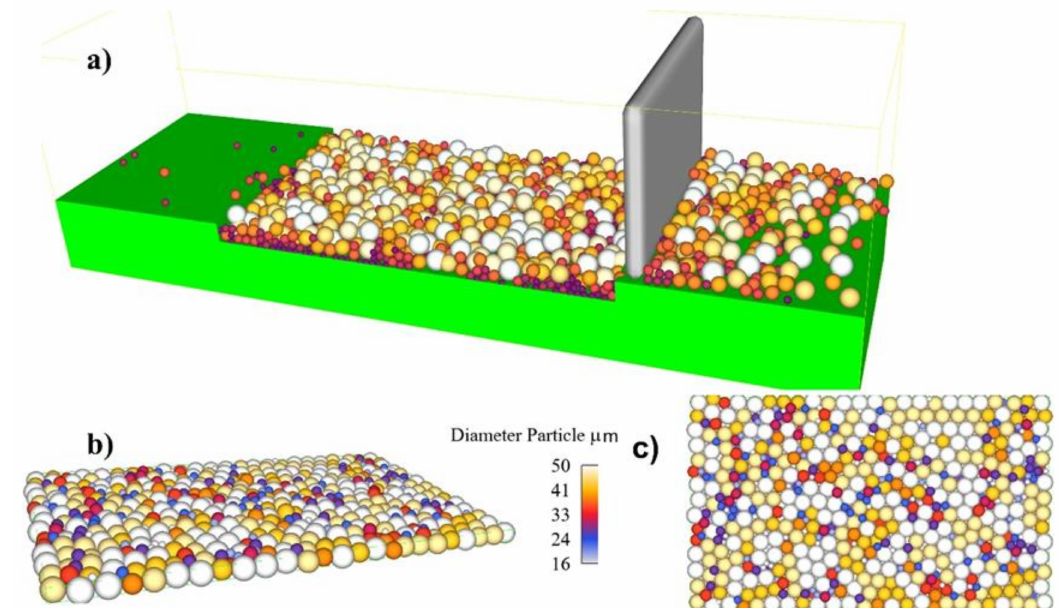
Figure 2. ( a ) Powder bed deposition, and ( b ) 30-micron deposited layer isometric and top view, and ( c ) side view.